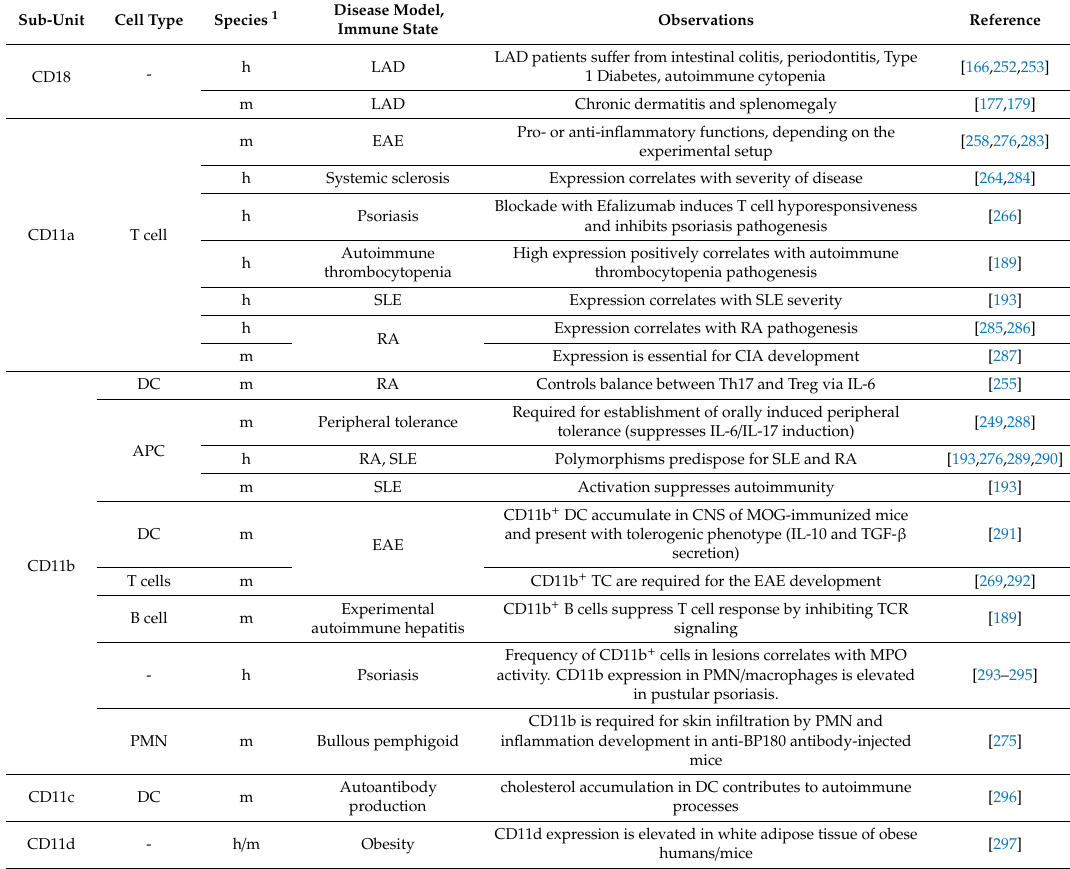
Table 1. Role of β 2 integrins in autoimmune